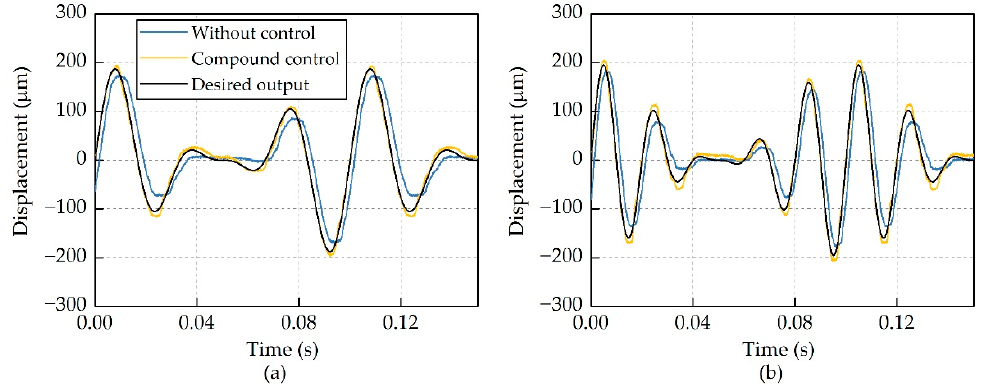
Figure 13. Hysteresis suppression for multiple-sinusoidal actuation signals. ( a ) 20 Hz, 30 Hz, and 40 Hz. ( b ) 40 Hz, 50 Hz, and 60 Hz.